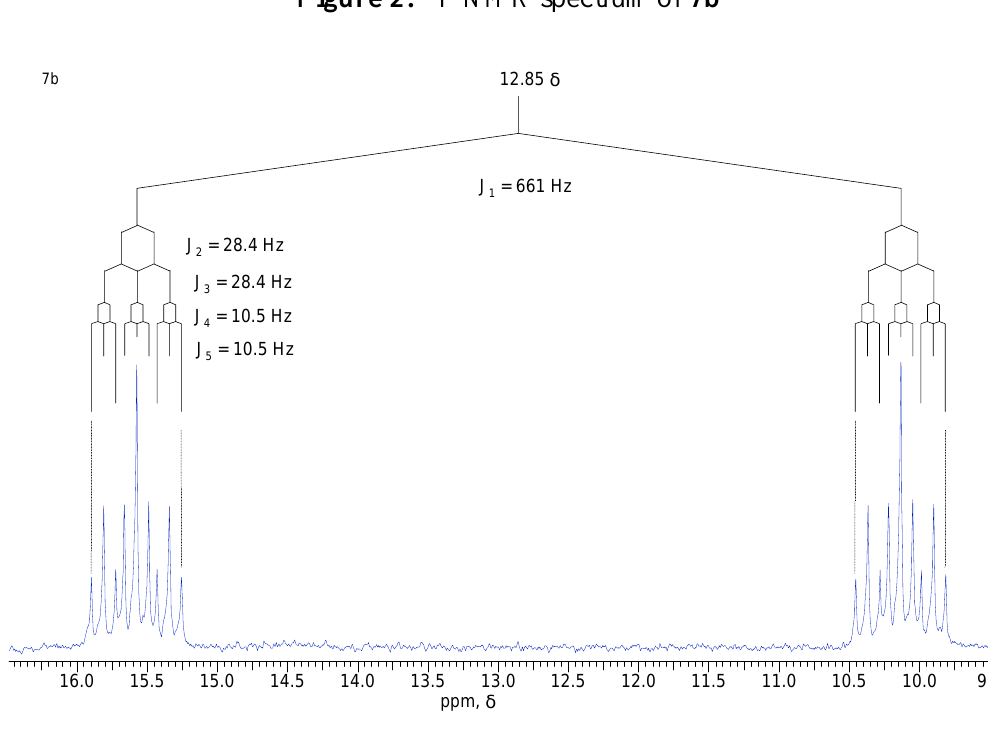
Figure 2. 31 P NMR spectrum of